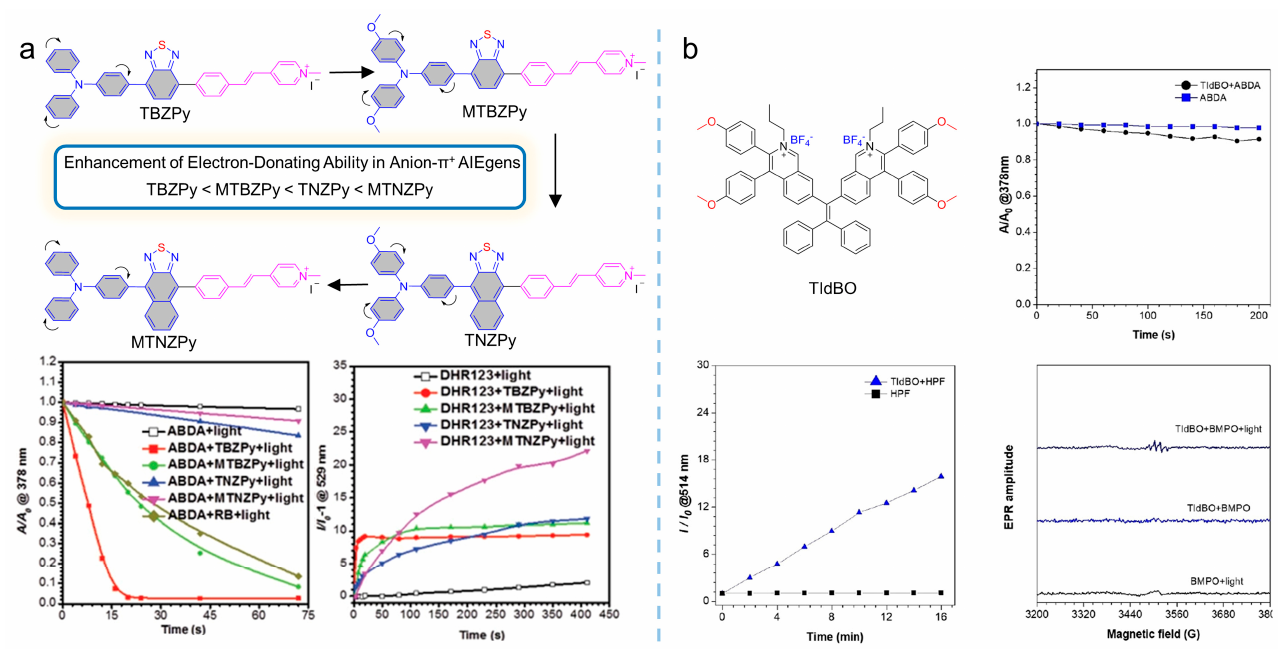
Figure 7. Anionization strategy to enhance ROS generation. ( a ) Molecular structure and ROS generation of TBZPy, MTBZPy, TNZPy, and MTNZPy indicated by ABDA and DHR123. Reprinted with the permission of the authors of [45]. Copyright 2020, Wiley-VCH GmbH. ( b ) Molecular structure, ROS generation of TIdBO indicated by ABDA, HPF, and EPR spectra of the TIdBO. Reprinted with the permission of the authors of [46]. Copyright 2021, American Chemical Society.